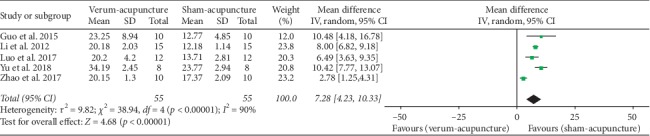
Forest plot of verum- versus sham-acupuncture in time spent in the original platform quadrant.